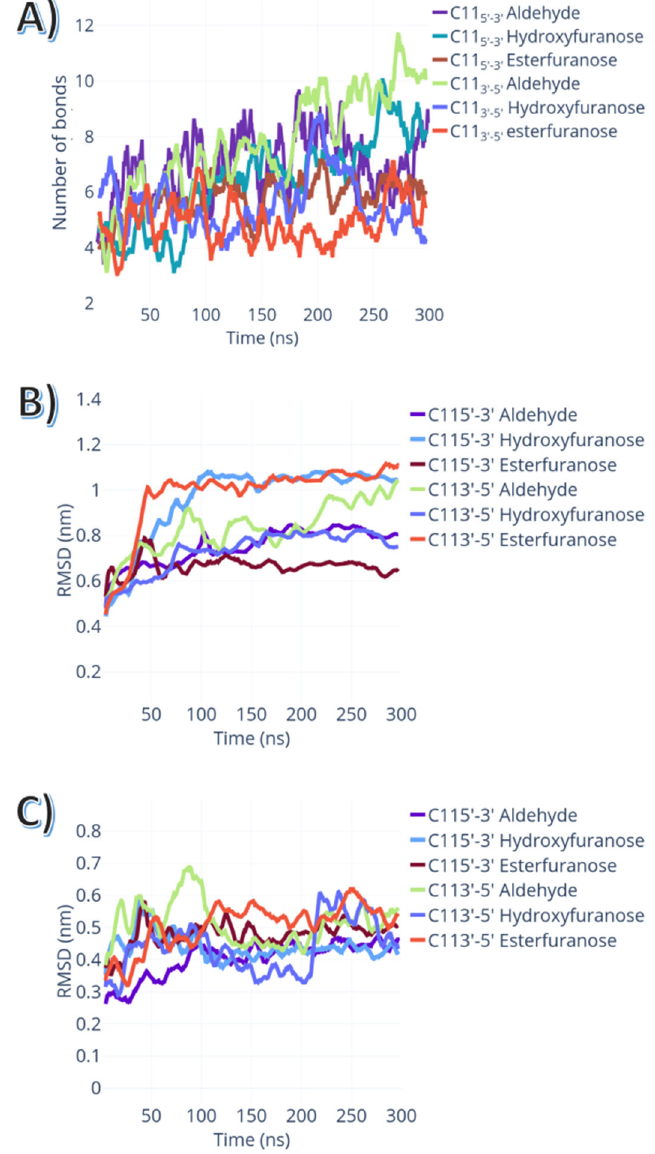
Figure 7. Impact of different abasic lesions on the intrinsic dynamics of the AR-DNA complexes. ( A ) the total number of hydrogen bonds between AR-DBD domain and the lesioned ARE element. ( B ) Protein RMSD in relation to the whole ternary complex structure vs. simulation time. ( C ) DNA RMSD in relation to the whole ternary complex structure vs. simulation time.